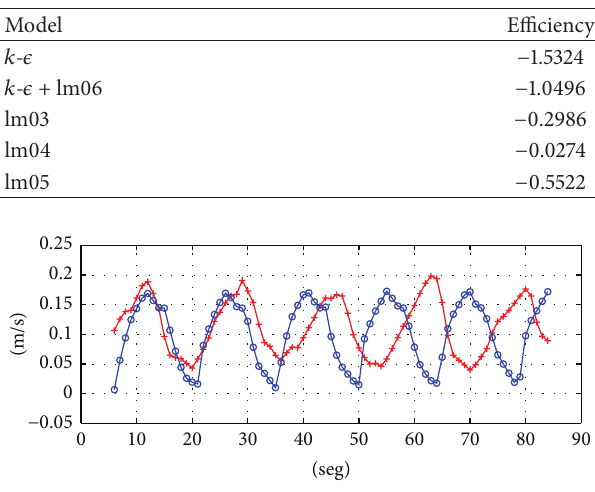
Figure 8: Comparing measurement data (+) and simulated data ( ∘ ) of the velocity component 𝑈 on the viewer 𝑉 1 obtained by Stansby and Lloyd [6]. The last 90seg of simulation are shown when the flux is considered to be